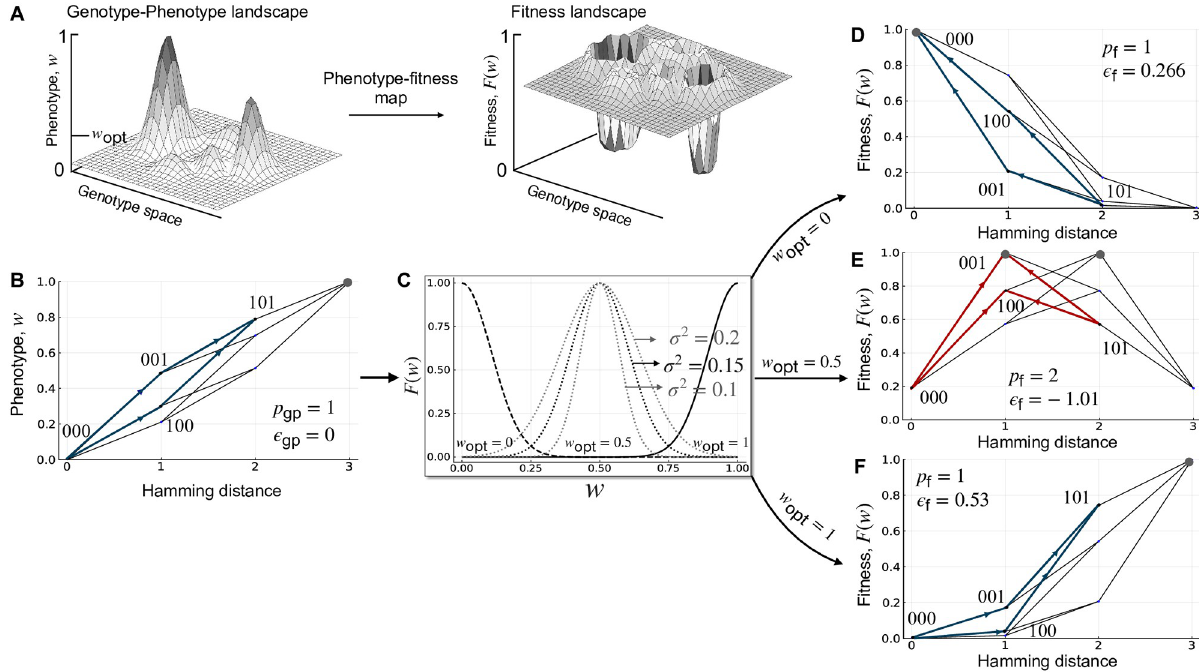
Fig 1. Incongruence. (A) Schematic illustration of how selection for an intermediate phenotypic value w opt can make a genotype-phenotype landscape incongruent with the resulting fitness landscape. (B) An additive three-locus, biallelic genotype-phenotype landscape with a single peak (gray filled circle; p gp = 1). One pairwise interaction is highlighted in blue. It exhibits no magnitude epistasis ( � gp = 0) or sign epistasis. (C) The Gaussian phenotype-fitness map (Eq 1) is shown for three values of w opt (dashed line, w opt = 0; dotted line, w opt = 0.5; solid line, w opt = 1), with three values of σ shown for w opt = 0.5. (D) Applying the Gaussian phenotype-fitness map with w opt = 0 to the genotype-phenotype landscape results in a single-peaked fitness landscape (gray filled circle; p f = 1). The same pairwise interaction from (B) is highlighted in blue. It exhibits positive epistasis ( � gp = 0.266), but no sign epistasis. (E) Applying the Gaussian phenotype-fitness map with w opt = 0.5 to the genotype-phenotype landscape results in a multi-peaked fitness landscape (gray filled circles; p f = 2). The same pairwise interaction from (B) is highlighted in red. It exhibits negative epistasis ( � gp = − 1.01), as well as reciprocal sign epistasis. (F) Applying the Gaussian phenotype-fitness map with w opt = 1 to the genotype-phenotype landscape results in a single- peaked fitness landscape (gray filled circle; p f = 1). The same pairwise interaction from (A) is highlighted in blue. It exhibits positive epistasis ( � gp = 0.53), but no sign epistasis. In panels B, D-F, arrows point from genotypes with lower phenotypic or fitness values to genotypes with higher phenotypic or fitness values. The no sign epistasis motif is highlighted in blue and the reciprocal sign epistasis motif in red. Note the symmetry of landscapes in panels D and